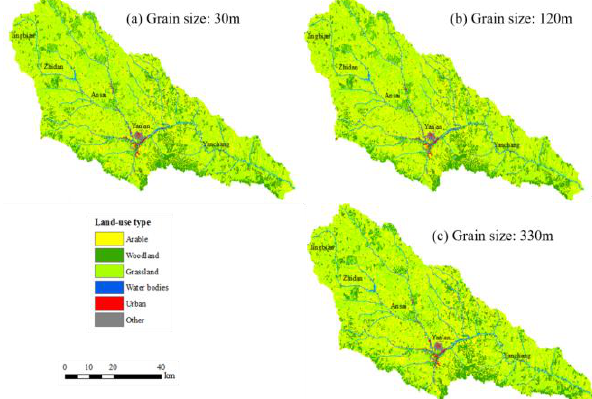
Figure 2. Land-use map of Yanhe watershed for 2015. Three different (a-c) grain sizes are